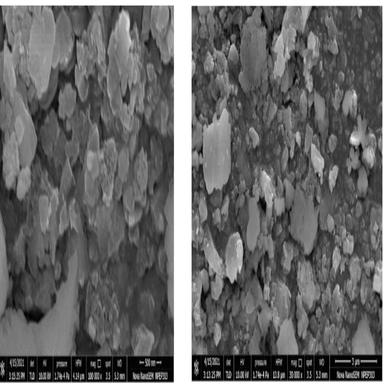
SEM analysis of 1 5 % nano mixed -PCM.